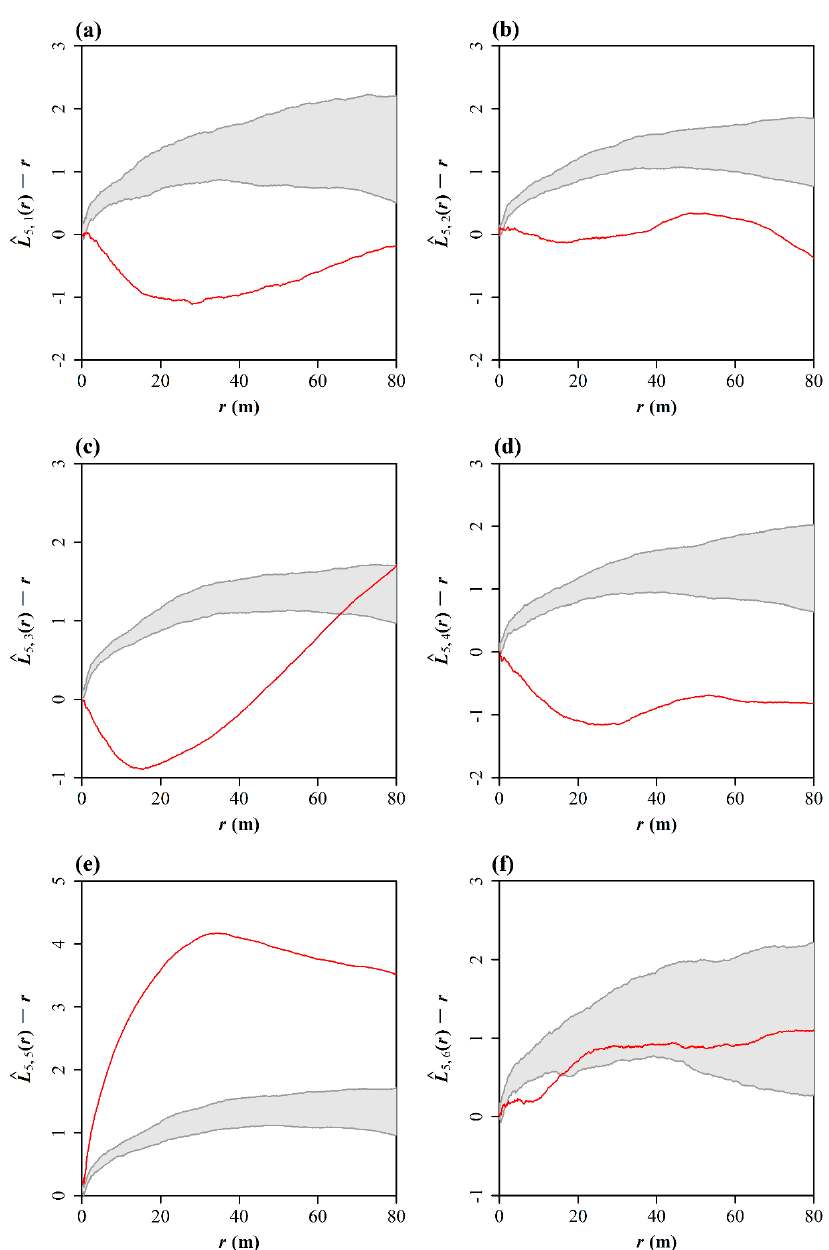
Figure 5. Analysis of spatial relationship between Chinese pine and five other tree species based on the randomization test of the random labelling null hypothesis. In the subscript of the estimated cross-type L , 1 represents F. chinensis , 2 represents S. reticulata var. amurensis , 3 represents Q. mongolica , 4 represents A. sibirica , 5 represents P. tabuliformis , and 6 represents U. pumila . The grey area are formed by simulation envelops; the red curve represents the difference between the estimated cross-type L of two types minus the corresponding distance scale r . ( a ) P. tabuliformis and F. chinensis ; ( b ) P. tabuliformis and S. reticulata var. amurensis ; ( c ) P. tabuliformis and Q. mongolica ; ( d ) P. tabuliformis and A. sibirica ; ( e ) P. tabuliformis and itself; ( f ) P. tabuliformis and U. pumila .